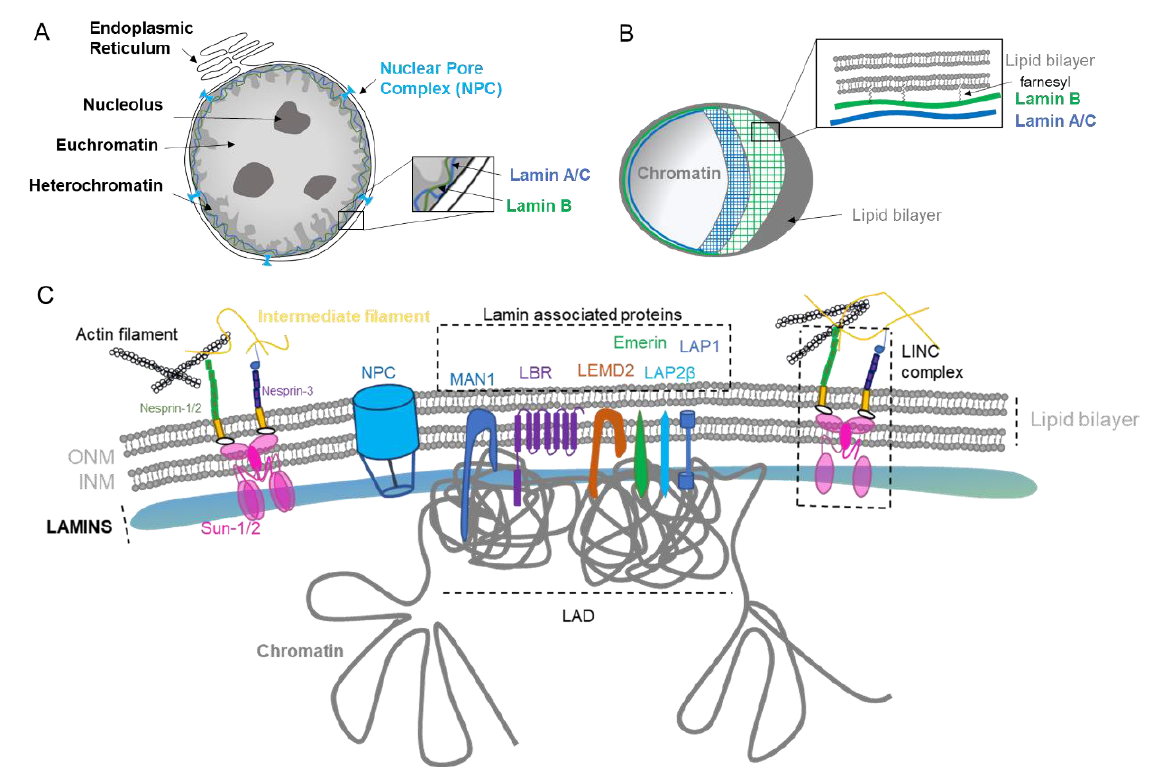
Figure 1. Nuclear envelope composition and organization. ( A ). The nucleus is surrounded by the nuclear envelope (NE). The Outer Nuclear Membrane (ONM) is continuous with the endoplasmic reticulum. The nuclear pore complex (NPC) regulates the export and import between the nucleus and the cytoplasm. The genome is organized in different compartments: euchromatin, heterochromatin, and nucleolus. ( B ). Structure of lamin layers in the Inner Nuclear Membrane (INM). ( C ). The NE is composed of a lipid bilayer anchored by several proteins forming the lamin-associated protein, the LINC complex, and by the lamins. The NE proteins regulate gene organization with the Lamin-Associated Domain (LAD).